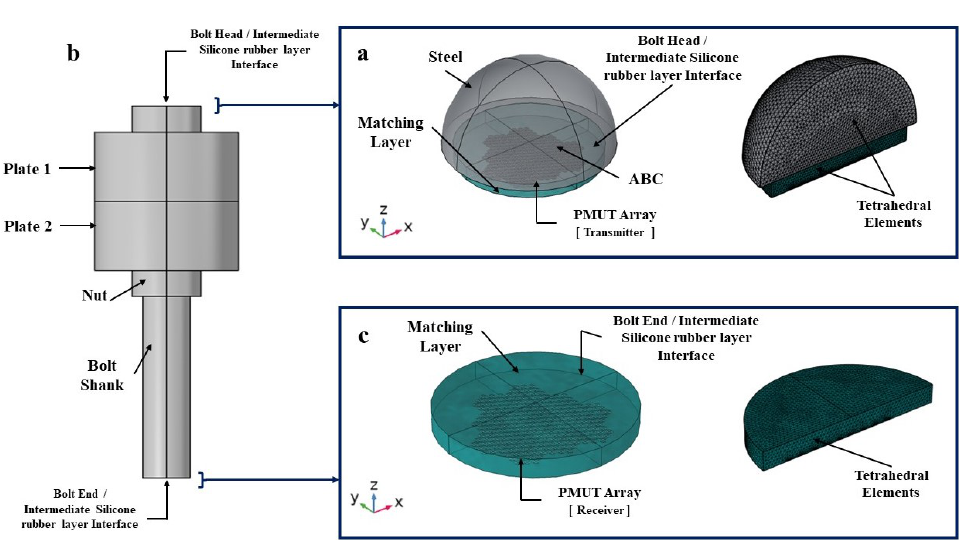
Figure 10. ( a ) Modeling of the transmission phase from the PMUT array into a truncated solid domain at the bolt head. ( b ) Modeling of the bolt only to simulate the acoustic wave propagation generated from the PMUT array. ( c ) Modeling of the reception phase of the acoustic wave arriving at the receiving array of PMUTs.